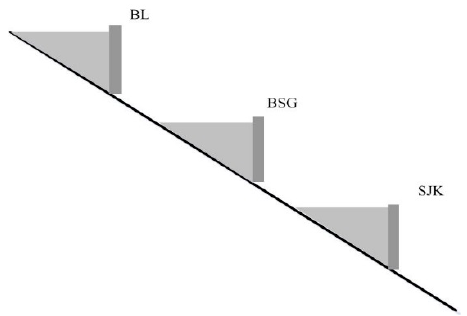
Figure 4. Cascade arrangement situation of BL-BSG-SJK.